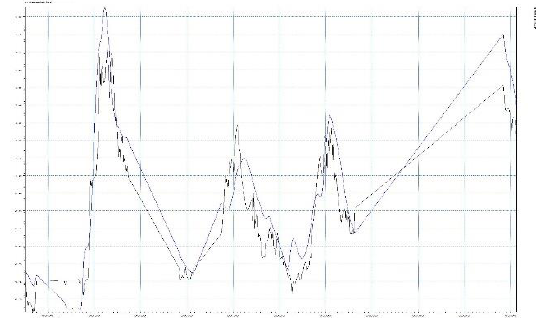
Figure 3. comparison the SWH derived from calibrated numerical model and measurement data for Amirabad